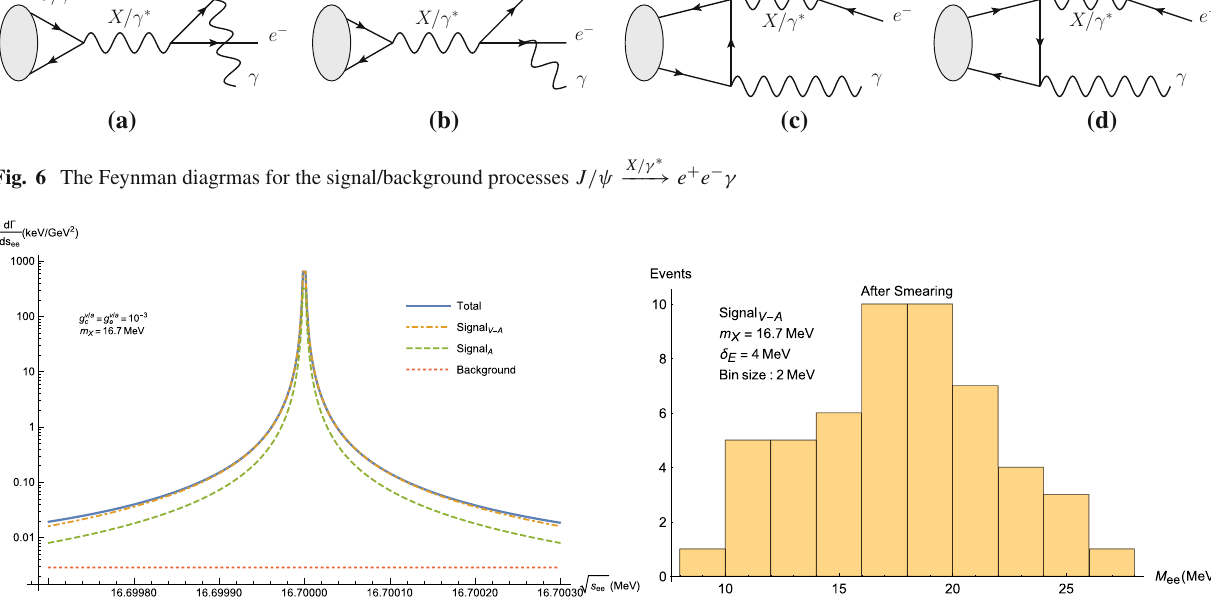
X /γ ∗ −−−→ e + e − γ processes.Right:theresonance